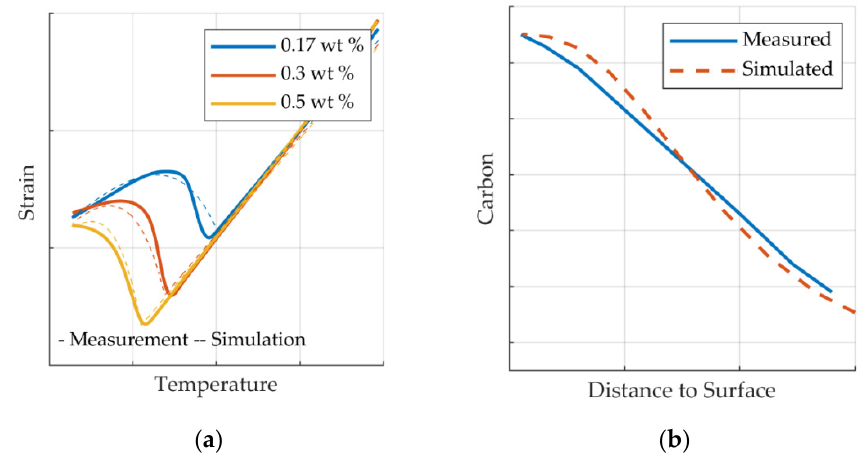
Figure 6. Validation of material parameters. Comparison of simulated and measured values of dilatometer and carburizing trials. ( a ) Dilatometry. ( b ) Carburizing. Explicit values for strain and for the carbon profile cannot be published due to confidentiality.